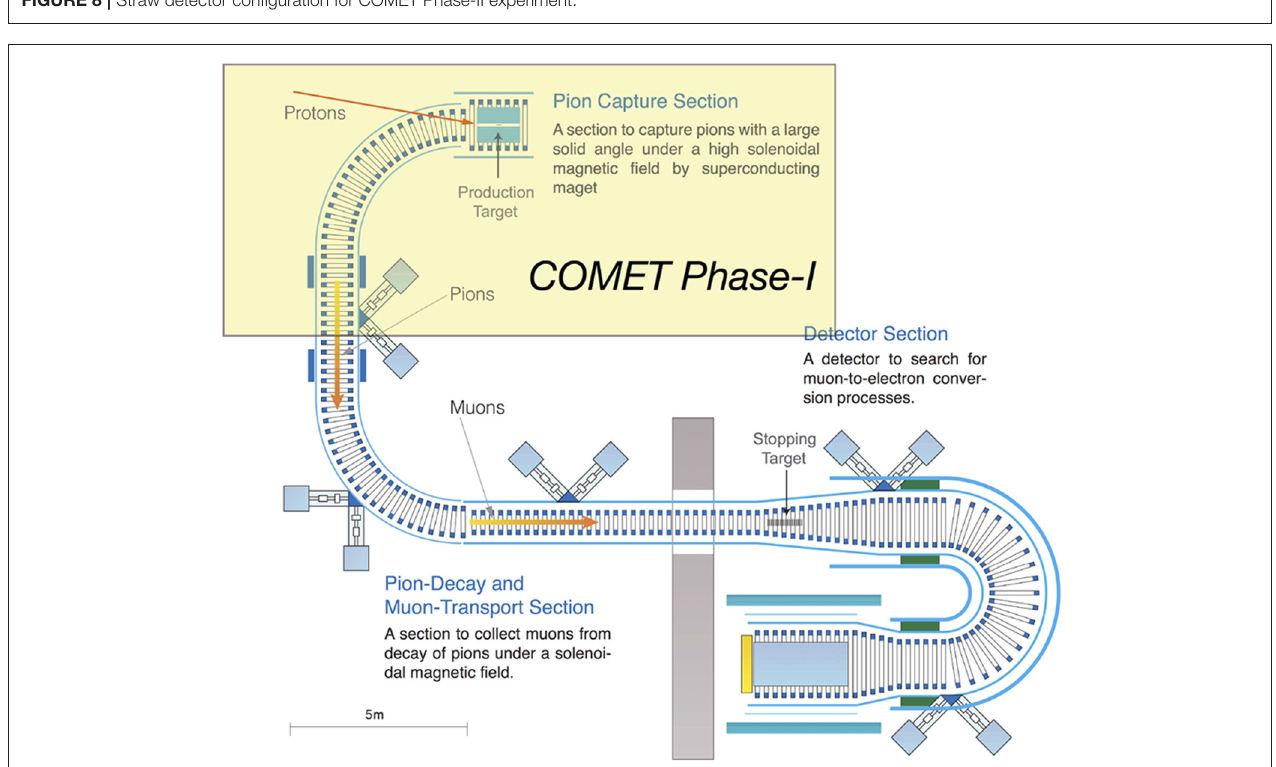
FIGURE 9 | COMET Phase-II experiment setup, compared with COMET Phase-I